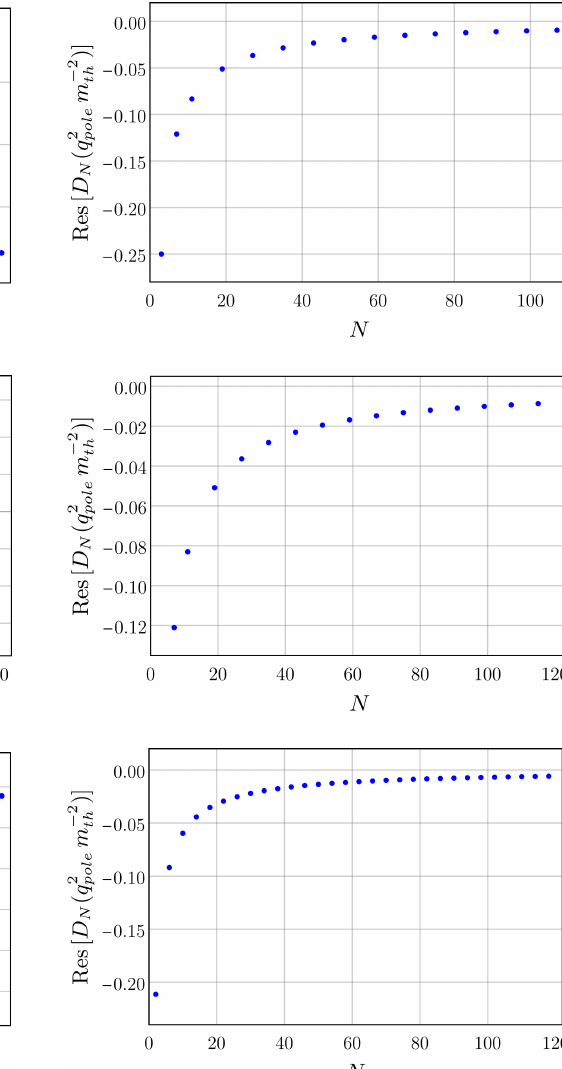
Figure 7 . Evolution of real poles (plots in the left column) and residues (plots in the right column) of truncations of the three test functions: P ( z ) = 1 + e z (top panel), P ( z ) = 1 + e − z 2 (central panel) and P ( z ) = (1 − z ) 1 / 2 (bottom panel). The first function, P ( z ) = 1 + e z , is entire. Its truncated version P ( z ) has one single real zero, which moves to infinity as N is increased. At the same N time, the corresponding residue approaches zero. The second (entire) function, P ( z ) = 1 + e − z 2 , is very similar to the first one, but in this case its truncated version has two real zeros, that evolve symmetrically. The corresponding residues are identical (every blue dot in the figure in the right panel is actually the overlap of two blue dots, corresponding to the residues of each pole). The third test function, P ( z ) = (1 − z ) 1 / 2 , has a finite radius of convergence and the single fictitious pole generated by truncations moves towards the boundary of the domain of convergence, | z | ≤ 1 , while the corresponding residue approaches zero, as